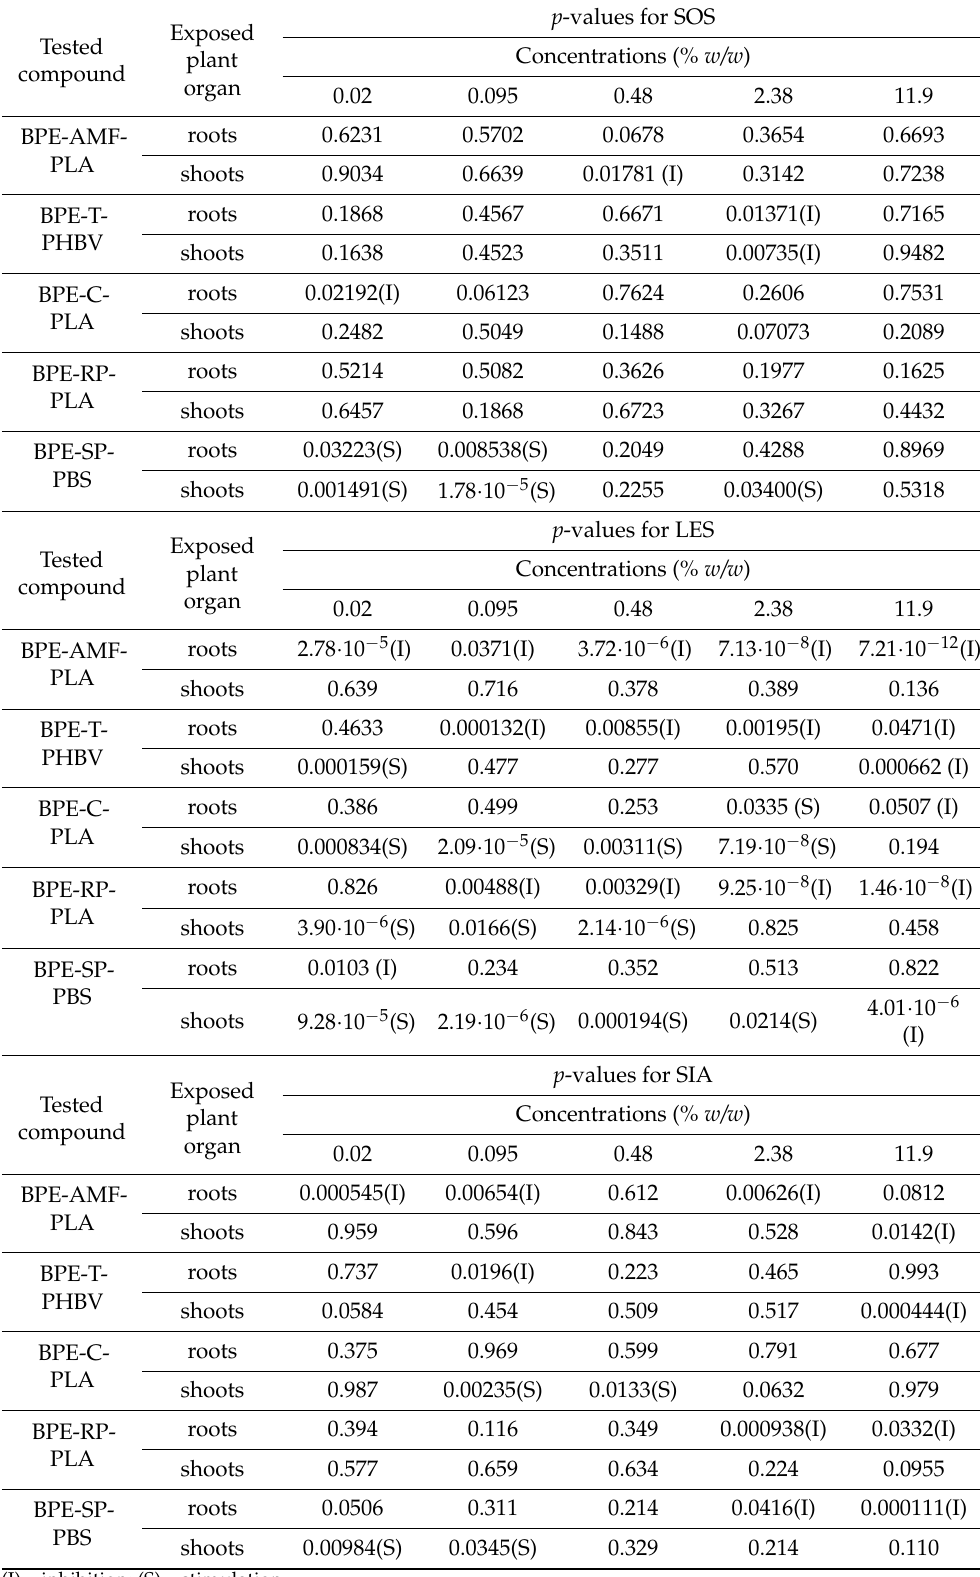
Table 2. Results of one-way ANOVA for S. saccharatum (SOS), L. sativum (LES) and S. alba